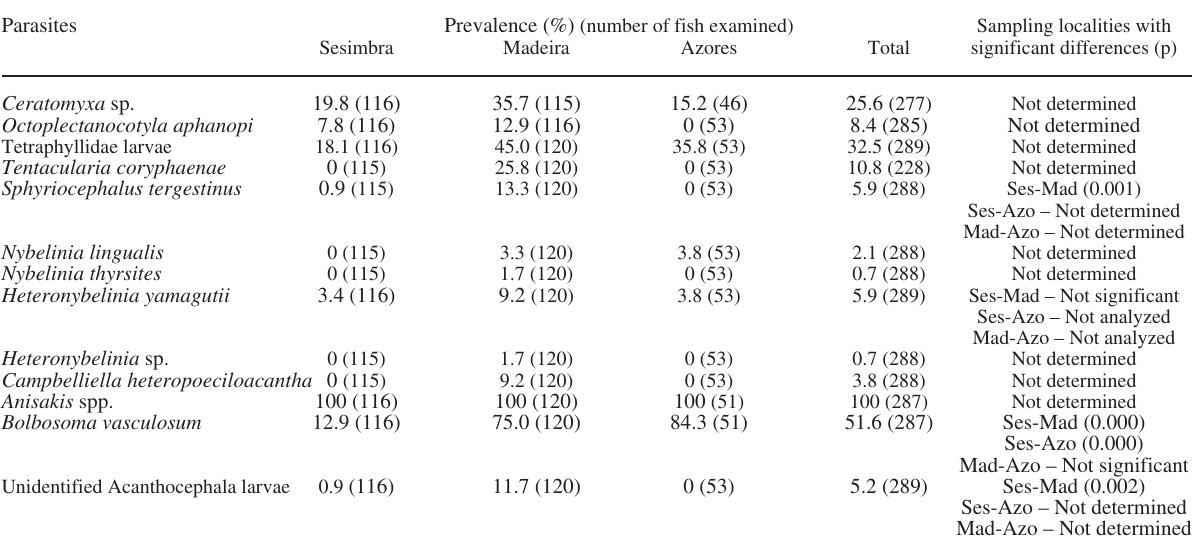
Table 4. – Prevalence of the parasites of Aphanopus carbo and statistical significance between the values obtained at the three sampling localities (Ses, Sesimbra; Mad, Madeira; azo, azores) determined by chi-square test. Parasites Prevalence (%) (number of fish examined) Sampling localities with Sesimbra Madeira azores total significant differences (p) Ceratomyxa